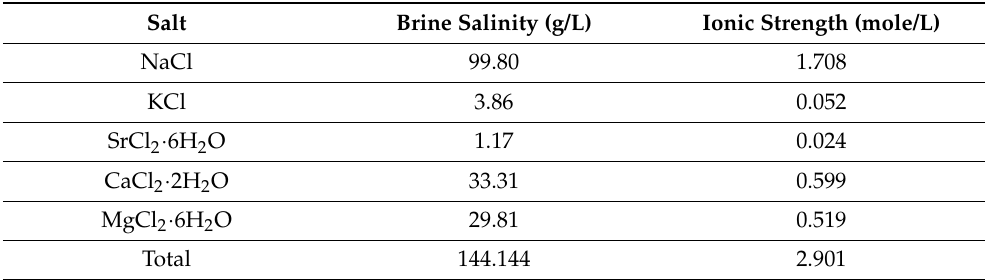
Table 1. Formation brine salinity